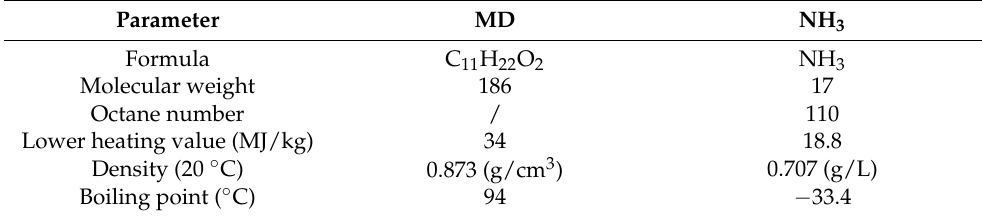
Table 2. Reference table of physical properties of methyl decanoate and NH 3 .